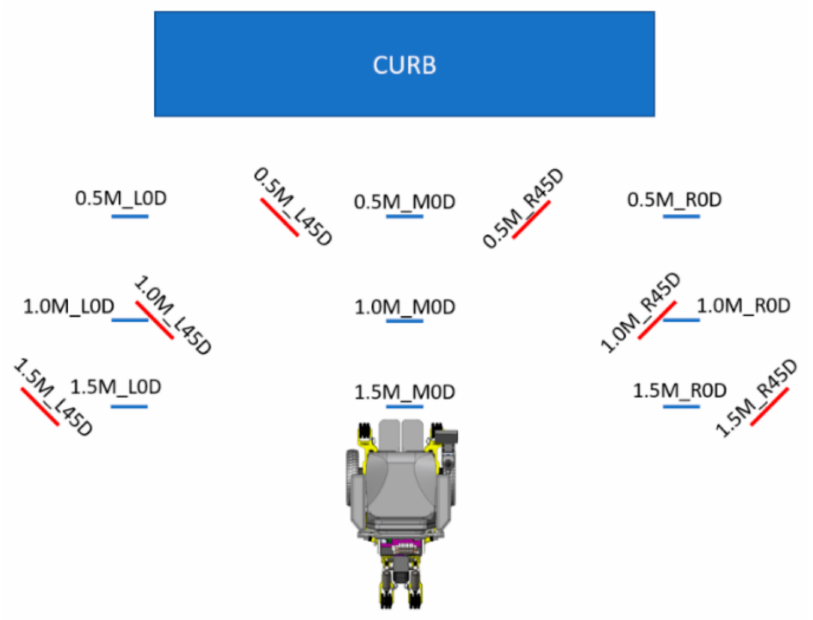
Figure 10. MEBot curb negotiation protocol diagram at 0.5–1.5 m away from the